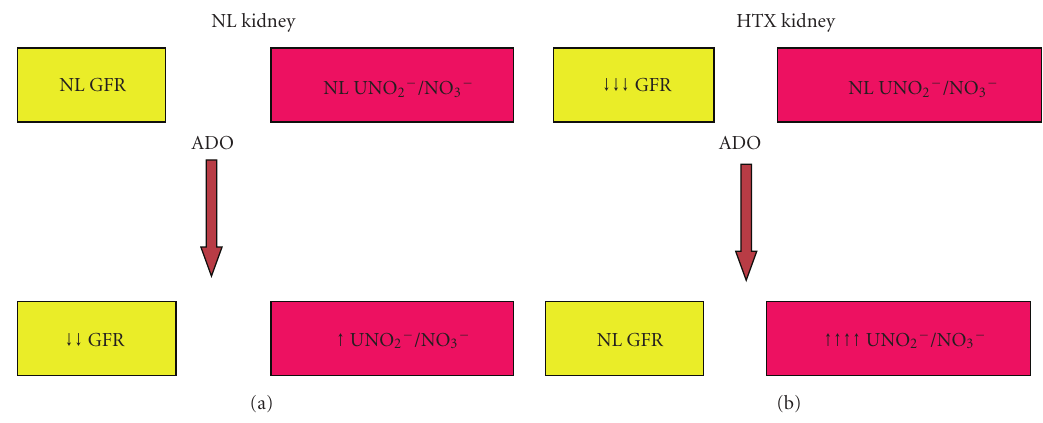
Figure 6: The e ff ect of adenosine on urinary excretion of NO 2 − /NO 3 − (NO 2 − /NO 3 − ). Exogenous adenosine induces a decrease of the glomerular filtration rate (GFR) in normal (NL) kidneys and slightly increases the urinary excretions of nitrites. In contrast, in the hypothyroid (HTX) kidneys, despite the vasoconstriction, the urinary excretion of nitrates is within the normal range. When exogenous adenosine is administrated to HTX kidney, the glomerular filtration rate returns to normal values but is associated with a marked increase in the UNO 2 − /NO 3 − , suggesting that this e ff ect is mediated by nitric oxide.